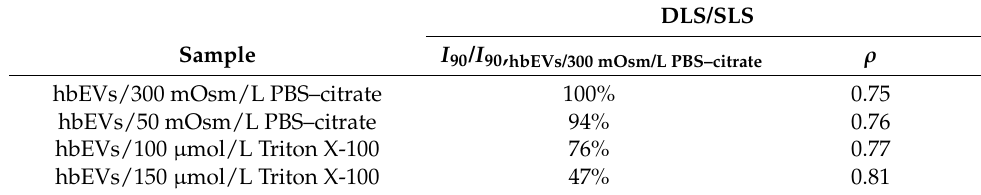
Table 1. Comparison of hbEVs at different conditions as observed by DLS/SLS. Light